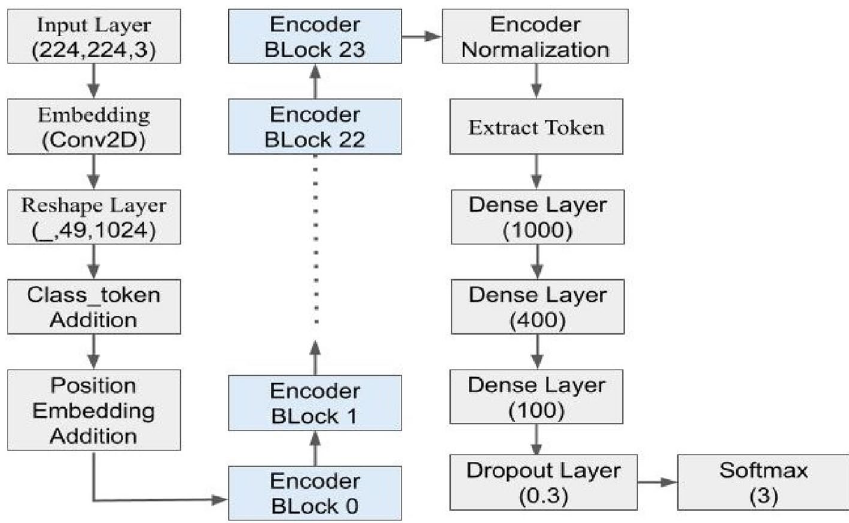
Figure 3. The diagram shows VIT-32 Model Architecture. It contains 24 transformer encoder blocks. The encoder block is shown in Fig. 2. in details. The arrows show the forward